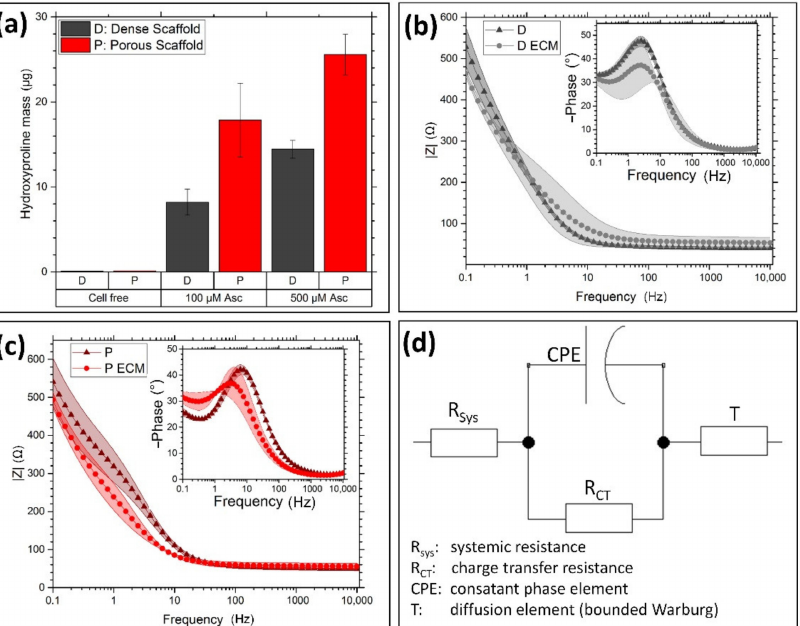
Figure 3. Electrode characterization. ( a ) The hydroxyproline assay showed proportional ECM formation by increased supplementation of L-Ascorbic acid 2-phosphate (Asc) as well as by increased electrode porosity ( n = 3). ( b ) Impedance spectroscopy of the dense scaffold as well as ( c ) the porous electrode showed a slight decrease in the amount of the impedance. ( d ) The measured impedance spectra ( n = 3) were fitted on the depicted electrical circuit to determine the single components.